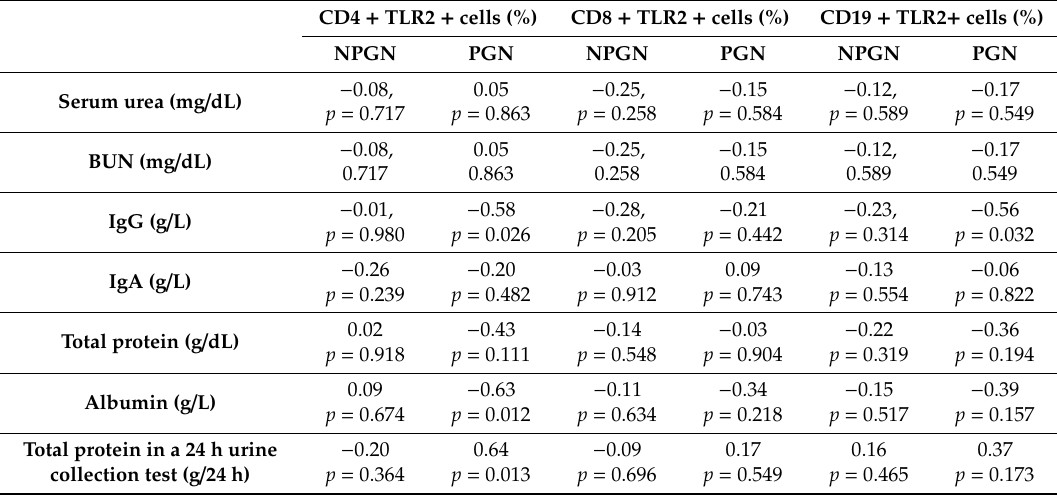
Table 4. Correlations between the frequency of TLR-2-positive lymphocyte subpopulations and selected laboratory variables in patients with proliferative glomerulonephritis (PGN) and non-proliferative glomerulonephritis (NPGN).